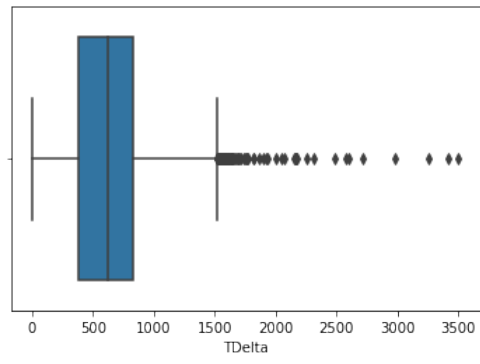
Figure 6. TDelta